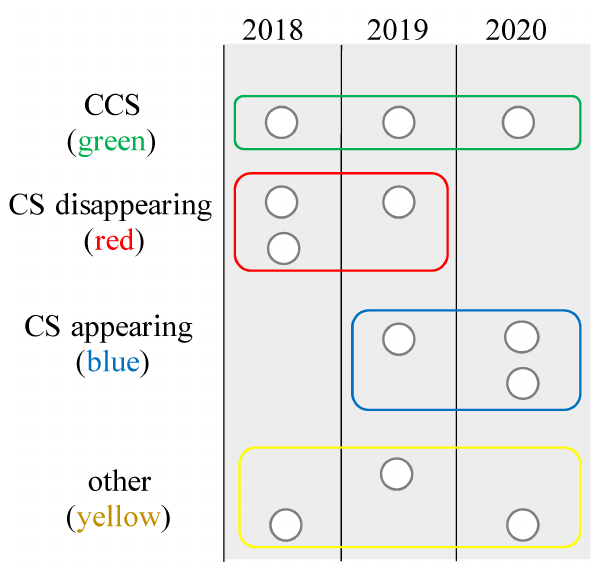
Figure 13. Schematic demonstration of class types in color representation. White circles indicate the existence of